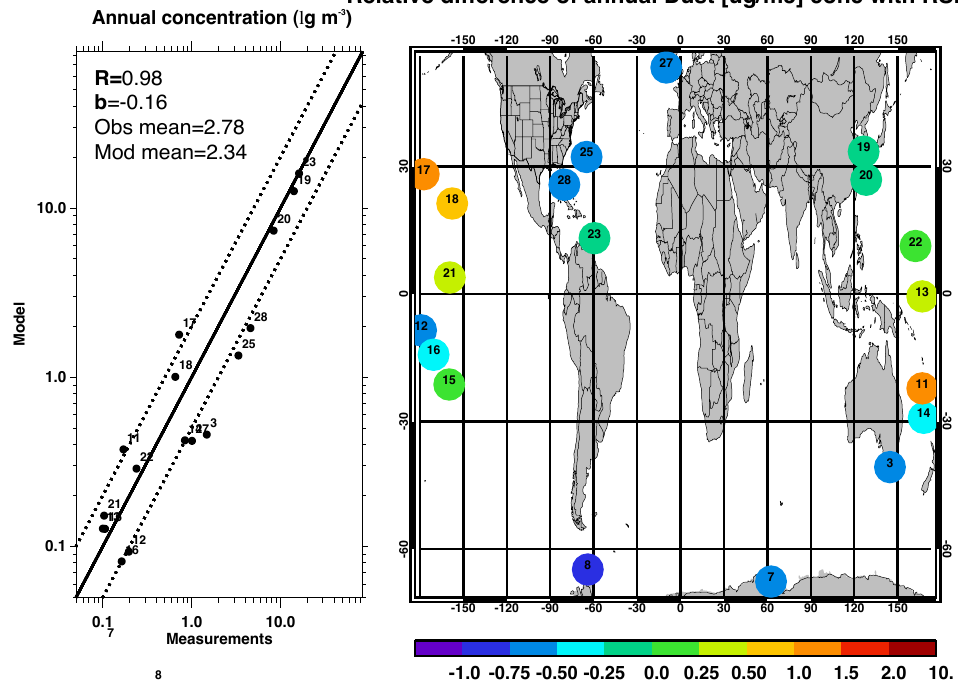
Fig. 13. The same as Fig. 10, but for dust.